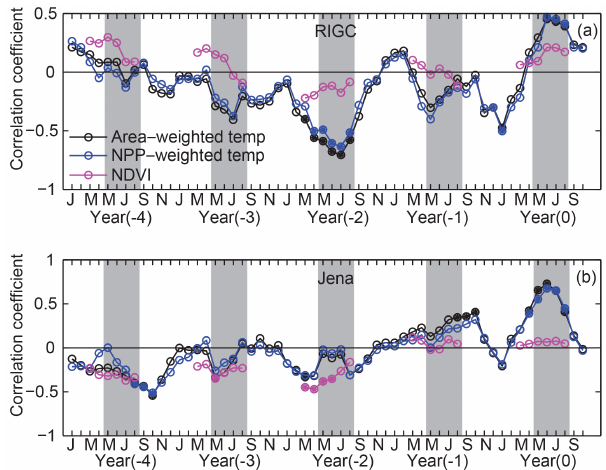
Figure 11. Correlation coefficients for July CO 2 fluxes in a given year (year 0) from the boreal zone with lagged 3-month running mean temperature (area-weighted and NPP-weighted) and NDVI for the same region. (a) RIGC inversion and (b) Jena s85 inversion over the current and previous 4 years. Positive correlations mean that high temperature or NDVI leads to less CO 2 uptake. Filled cir- cles indicate significance greater than the 95% level. Shaded bars indicate the summer months (May–August).